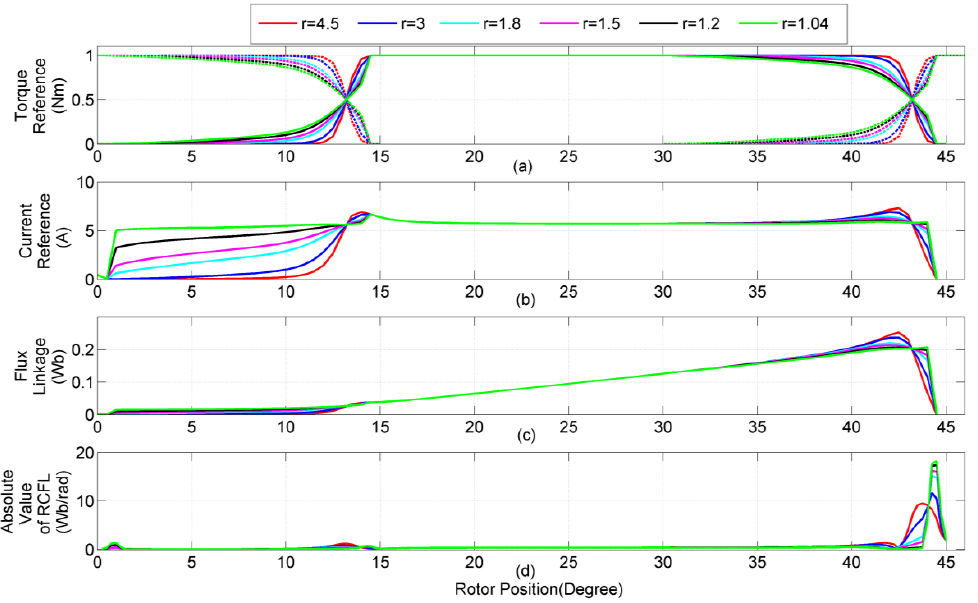
Figure 7. Typical profiles of the proposed TSF family. ( a ) Torque Reference; ( b ) Current Reference; ( c ) Flux Linkage; ( d ) Absolute Value of RCFL. ( c ) Flux Linkage; ( d ) Absolute Value of